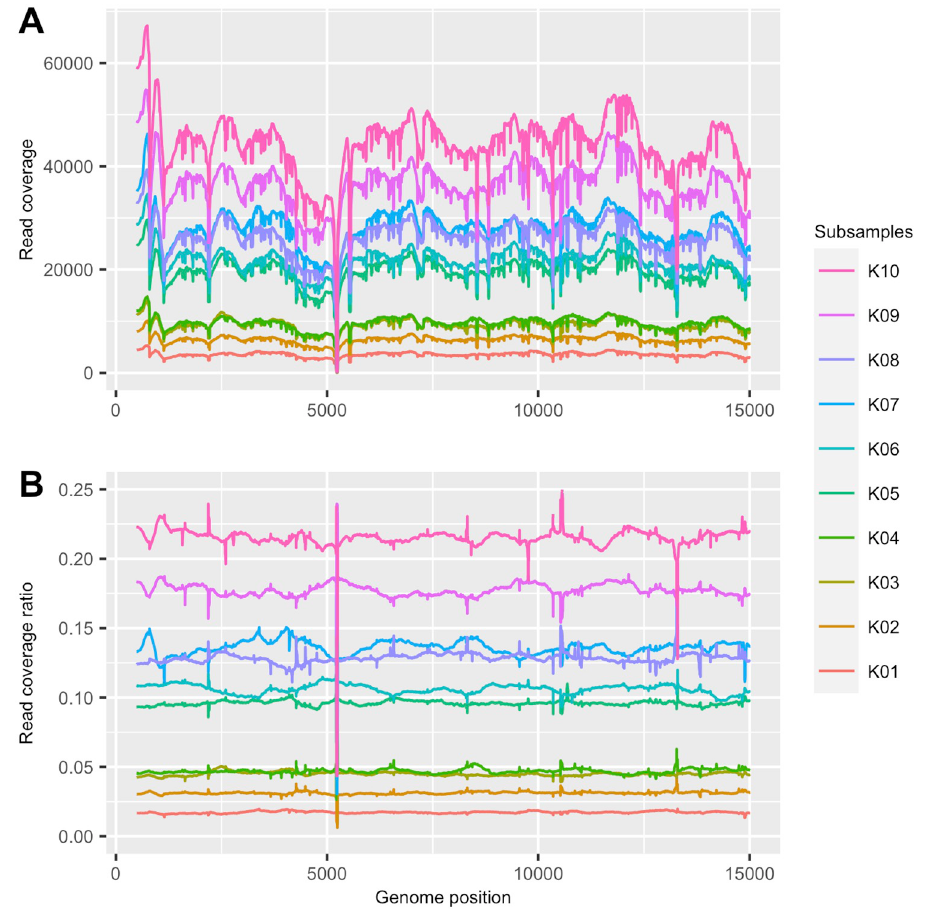
Fig 8. Distribution of the read alignments of 10 haplotypes against the reference genome. (A) The absolute read coverages along the genome. (B) The ratios on read coverages between sub-samples along the genome.